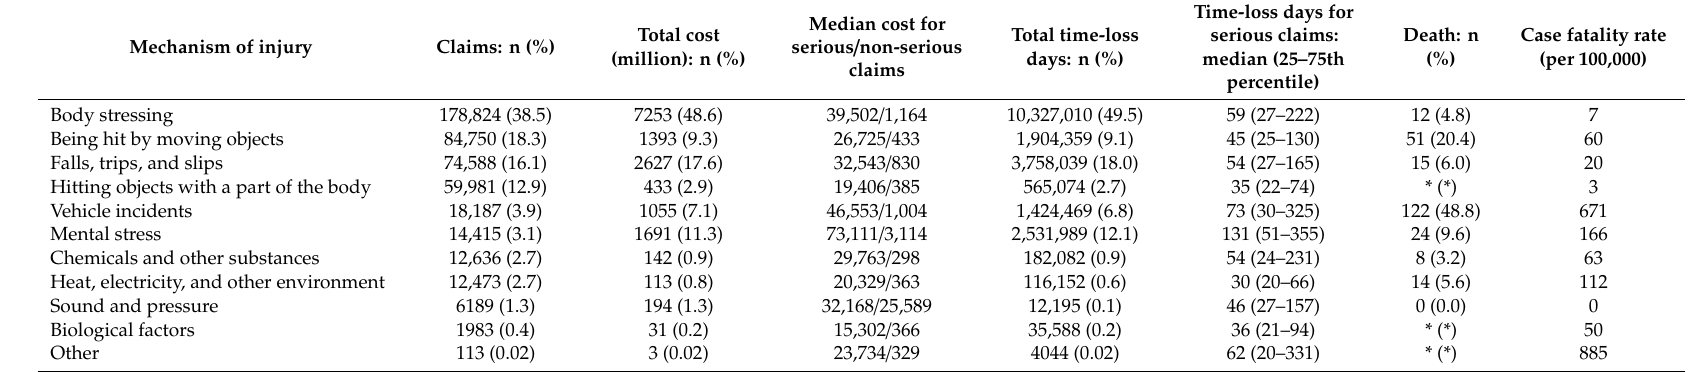
Table 4. The number of claims, percentage, compensation payment, time-loss days, and deaths by mechanism of injury, South Australia, 2000–2014.